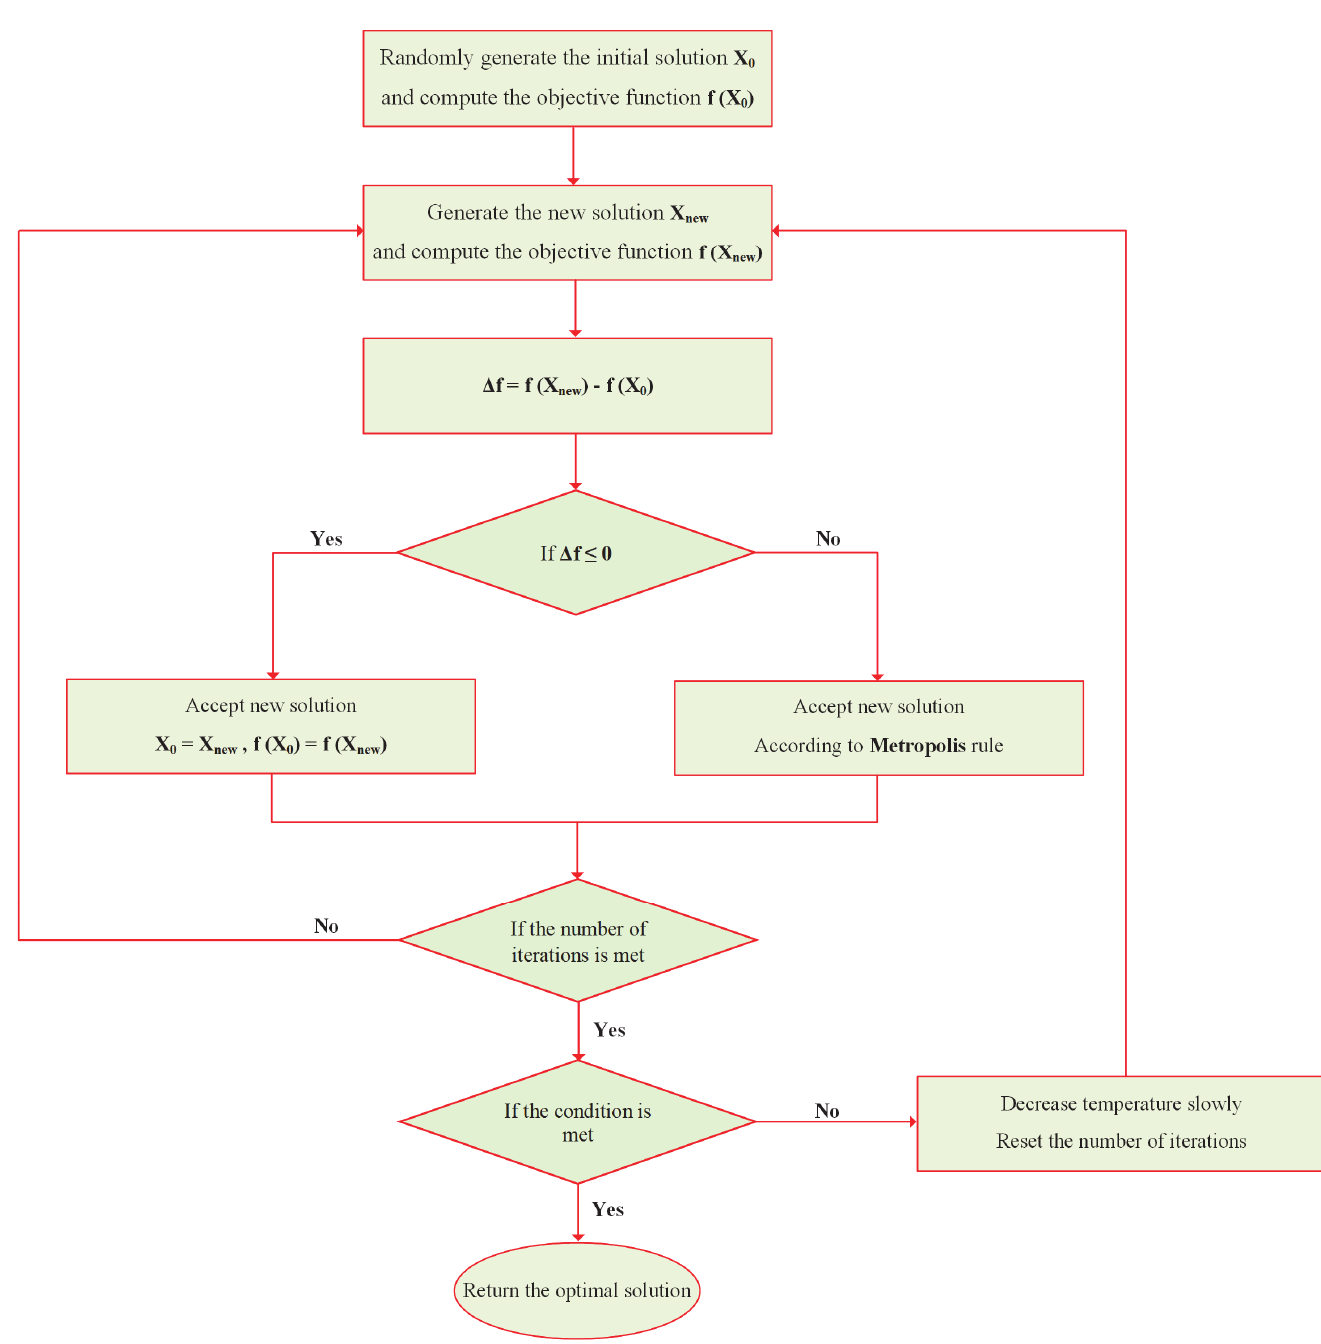
Figure 4: Flowchart of SA algorithm